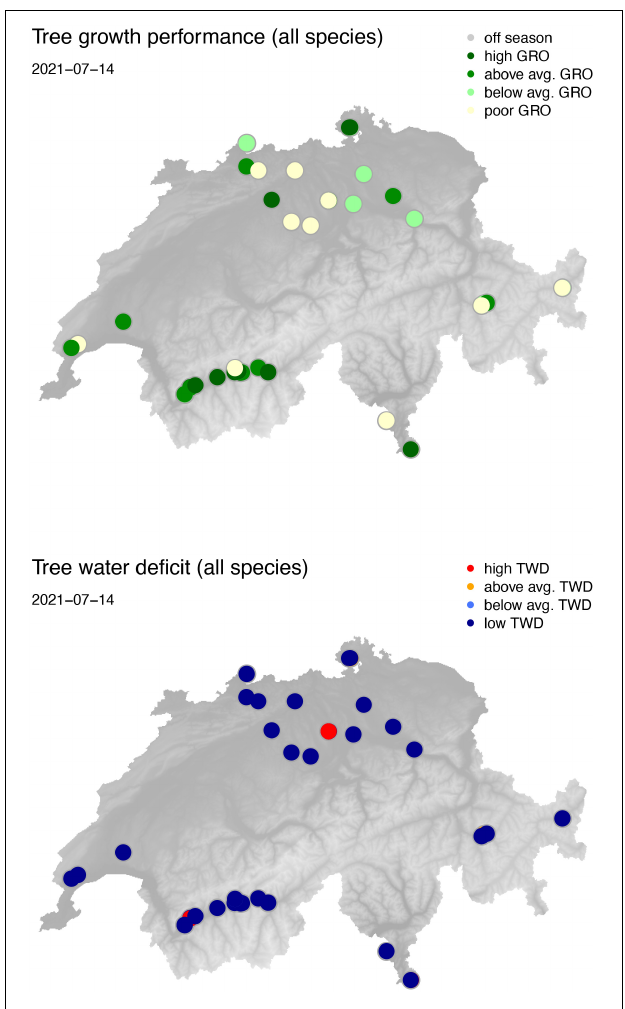
FIGURE 6 | Stem growth (GRO) and tree water deficit (TWD) status of all available TreeNet sites on 14 July 2021. Upper map shows the color-coded growth performance, the lower map shows the same for TWD. Actual maps can be found under https://treenet.info. Color codes correspond to the ones shown in Figure 5